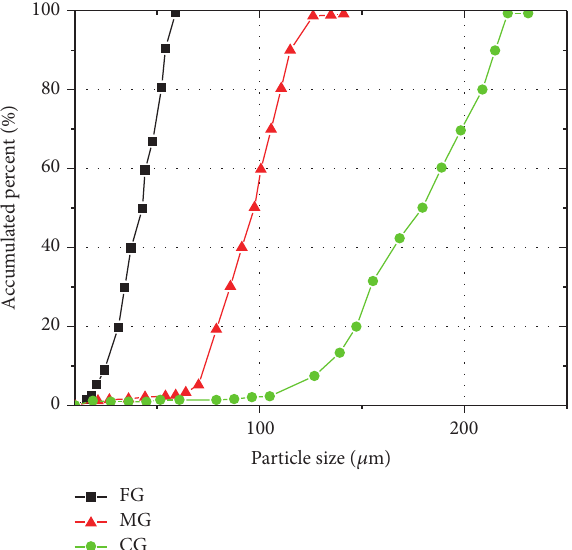
Figure 4: Initial grain size distribution of the granular sample.